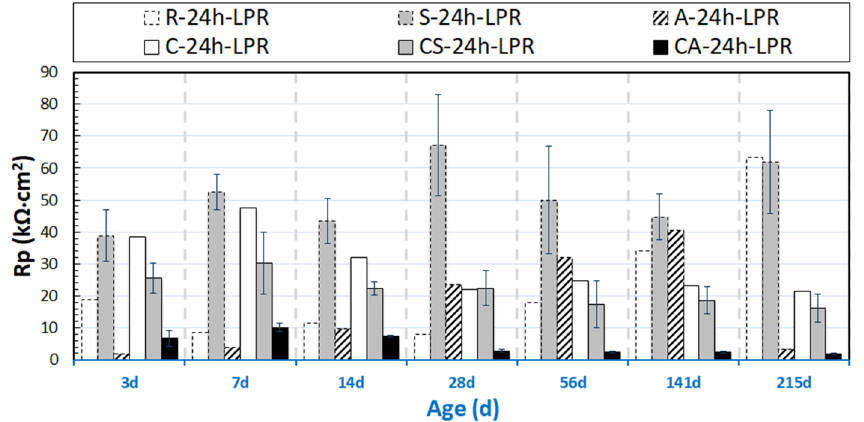
Figure 4. R p evolution of 24h-cured samples (R-24h: Reference; S-24h: Stray Current; A-24h: An- odic Polarization; C-24h: NaCl medium; CS-24h: NaCl + Stray Current; CA-24h: NaCl + Anodic Polarization).